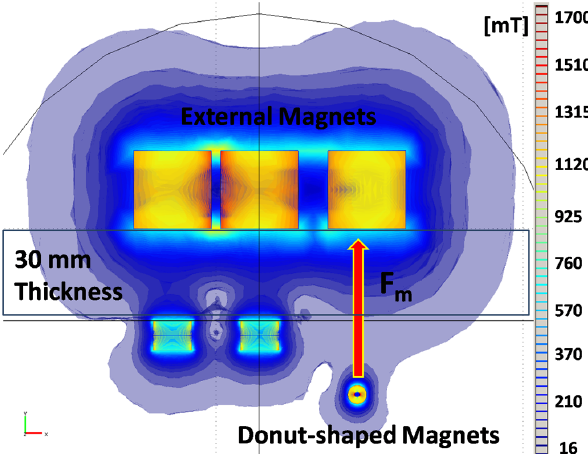
Figure 10. Evaluation of the tilt span. (a) Bench test scenario. (b) The maximum attraction force keeps the robot head near the ab- dominal wall. (c) Equilibrium point: F m is negligible and the head tilt angle is 60 ◦ . (d) The repulsive magnetic force pushes down the head that reaches a final angle of 80 ◦